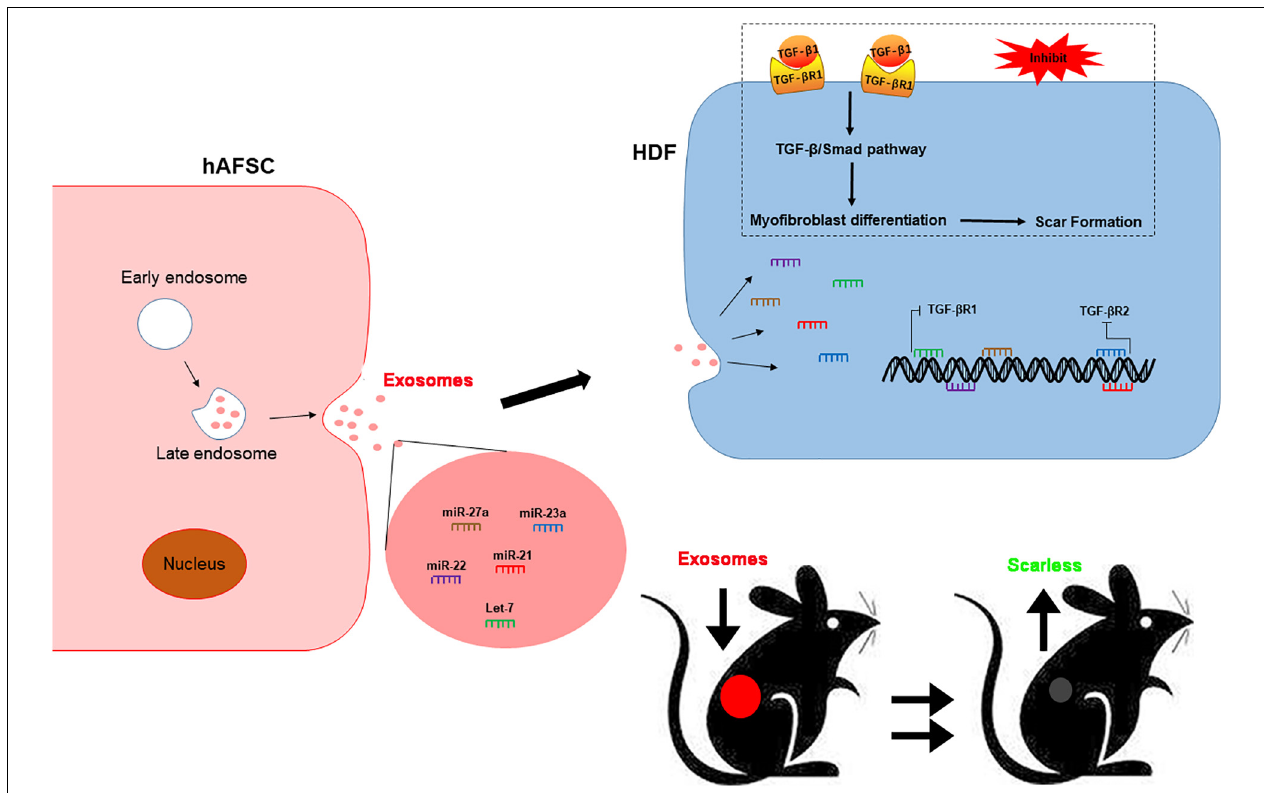
FIGURE 9 | hAFSC-exo improves regeneration and suppresses fibrotic scarring by inhibiting the TGF- β signaling pathway. Let-7-5p, miR-22-3p, miR-27a-3p, miR-21-5p, and miR-23a-3p carried by hAFSC-exo may inhibit myofibroblast formation by down-regulating the expression of TGF- β R1 and TGF- β R2 in the TGF- β signaling